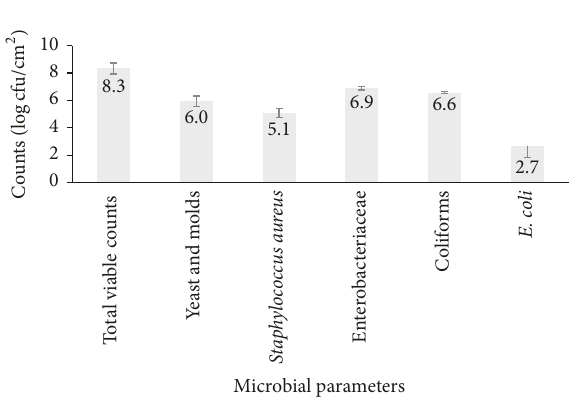
Figure 2: Microbial counts on Orange Fleshed Sweet Potato puree handlers’hands;thevaluesabovethebarsrepresentthemean ± SEM (standard error of the